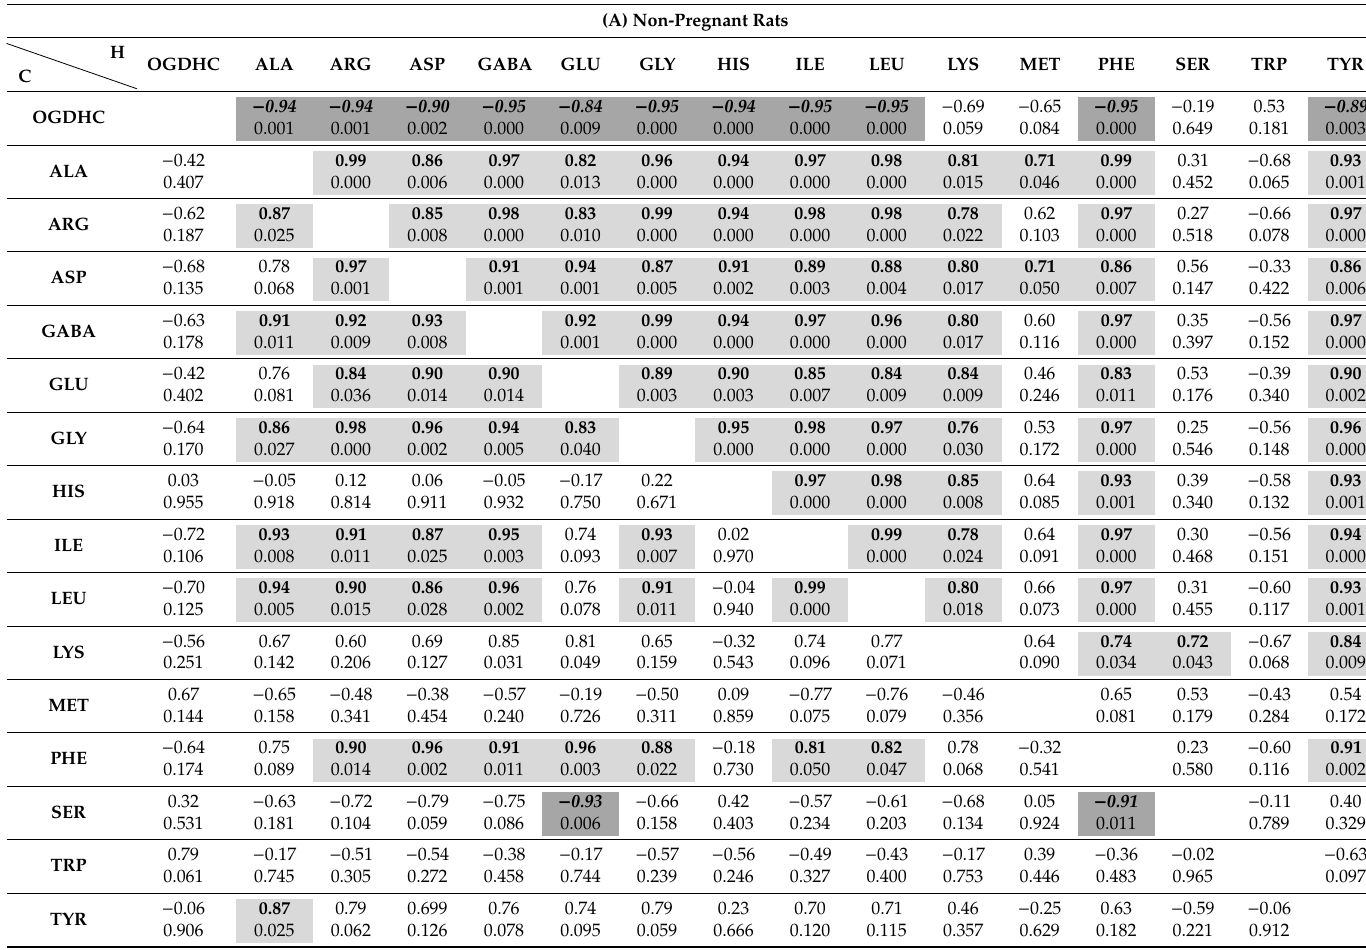
Table 3. Correlation matrices characterizing interdependence between the amino acid levels and OGDHC activity in the cerebella of the non-pregnant and pregnant rats from the control (C) and hypoxia-exposed (H)